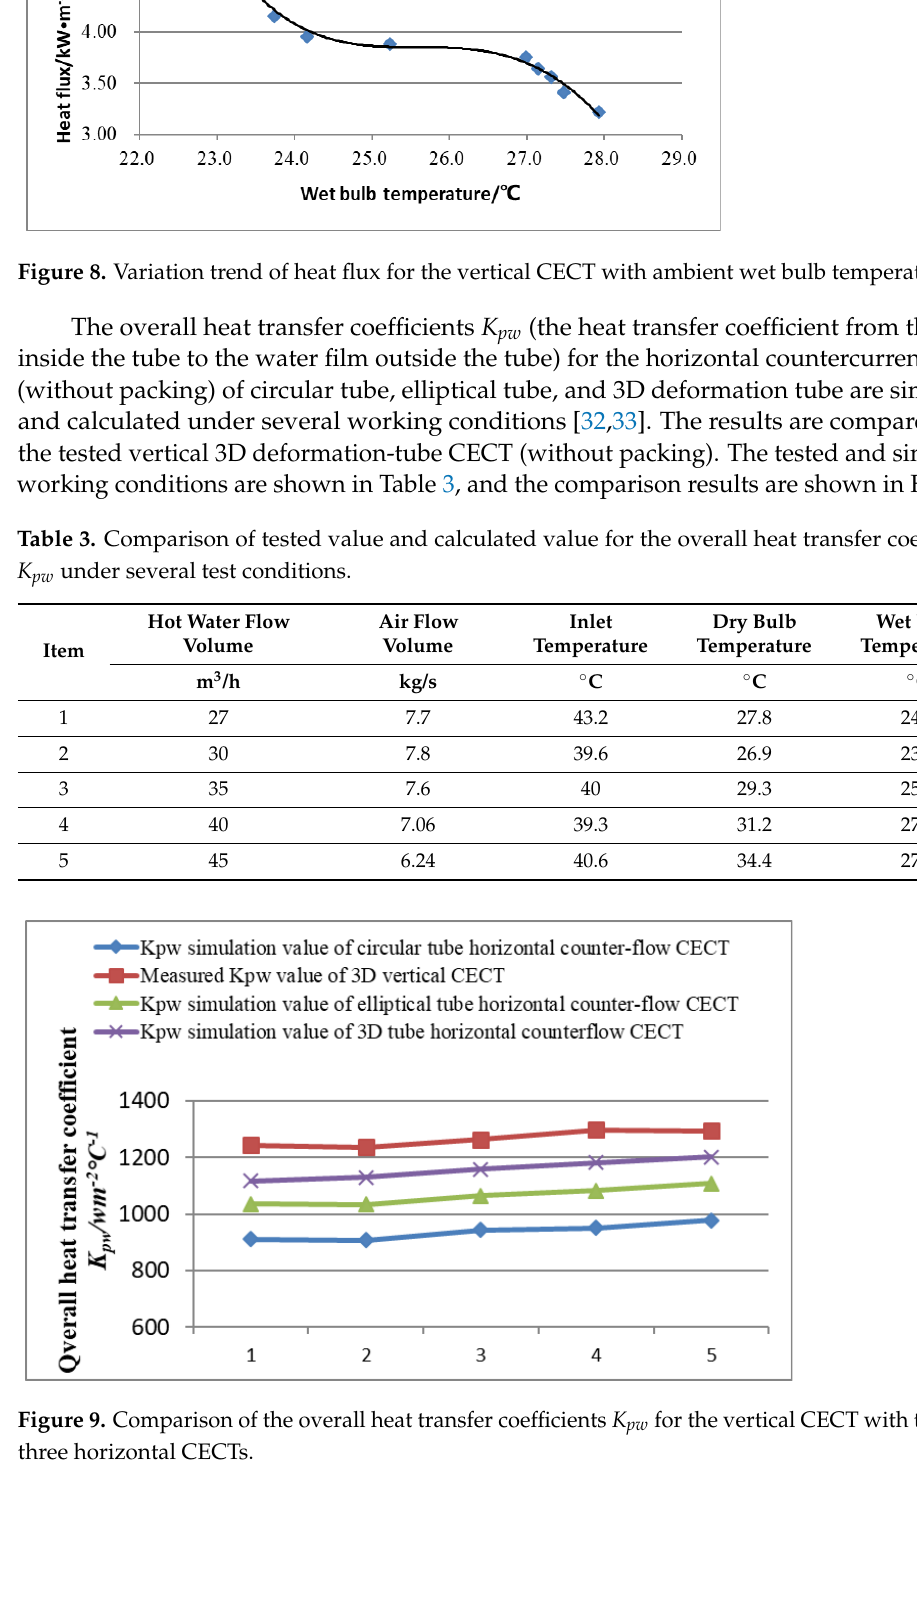
10 of 13 Figure 7. Comparison of the convective heat transfer coefficient of the water film outside the tube bundle under different operating conditions. Figure 8 shows the variation trend of heat flux in the vertical CECT with ambient wet bulb temperature under the same circulating water flow rate, the same spray density, and a similar inlet water temperature (38.5~40.6 °C). It can be seen that with the increase in the wet bulb temperature, the heat flux shows a downward trend. When the wet bulb tem- perature increased from 22.8 to 27.9 °C, the heat flux decreased from 4.98 to 3.22 kW/m 2 , a decrease of about 35%. In other words, within this range of wet bulb temperature, the heat flux is reduced by about 7% for every 1 °C increase in the wet bulb temperature. The